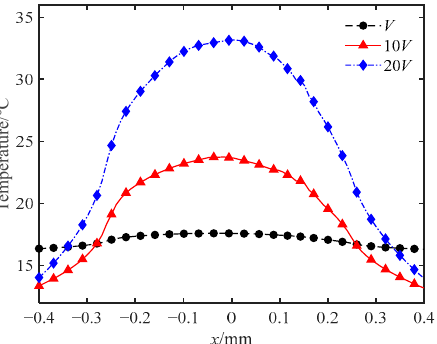
Figure 12. Variation pattern of temperature distribution with fretting speed.